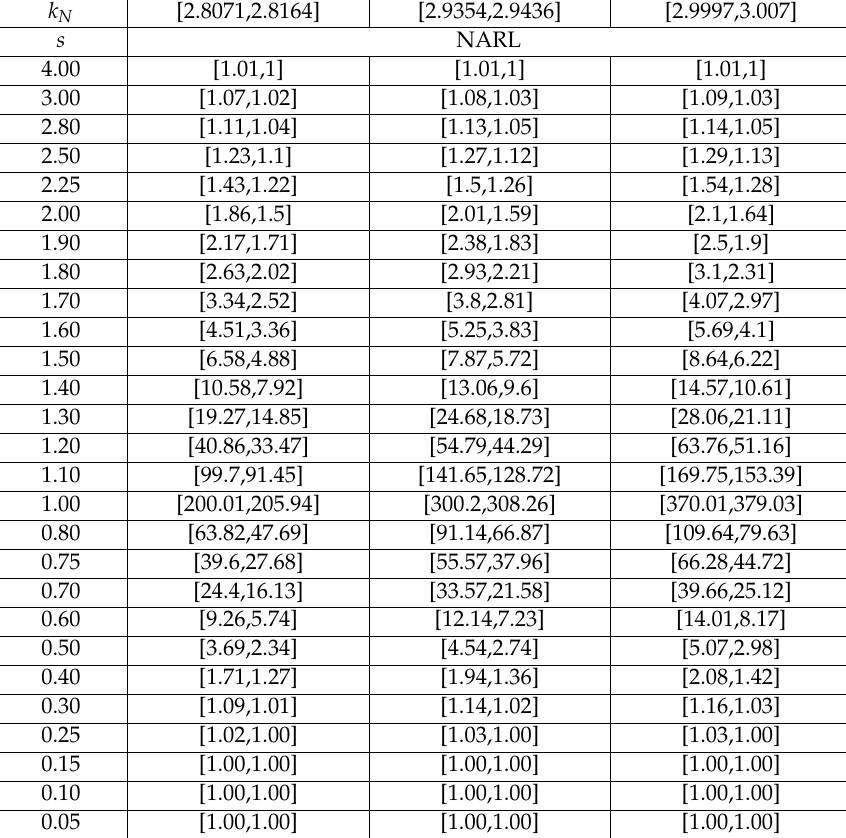
Table 2. The values of NARL when a N (cid:15) [ 1.95,2.05 ] and k N (cid:15) [ 8,10 ] .